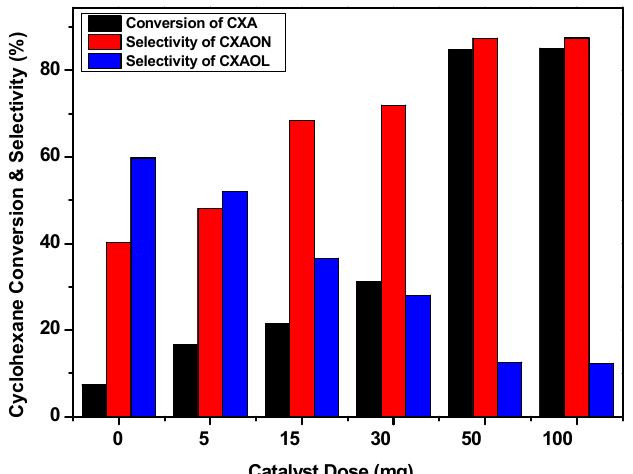
Figure 10. Catalyst dose effect. Reaction conditions: Catalyst is bulk NiO, m- CPBA, T = 70 °C, 24 h.